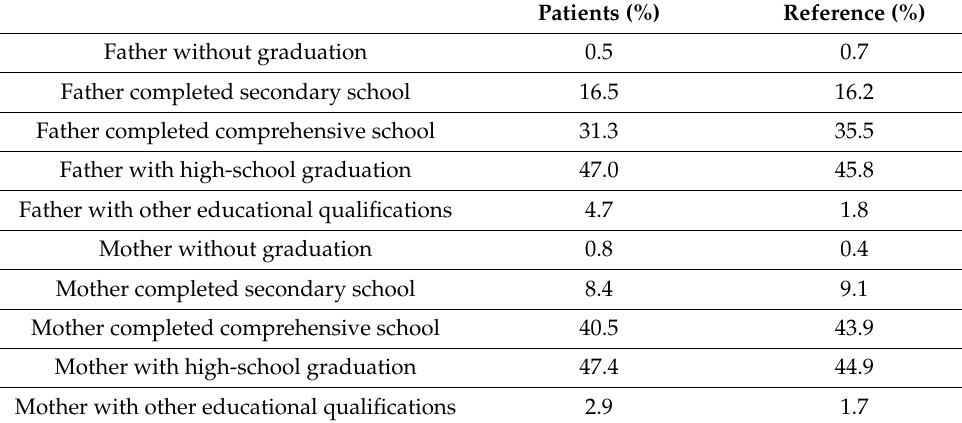
Table 4. Educational qualifications of parents (patients vs. reference).